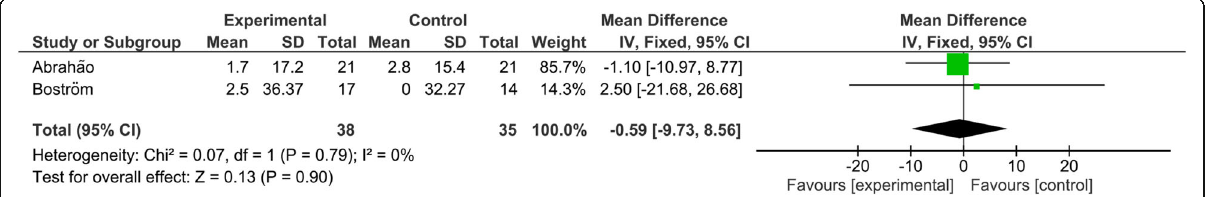
Fig. 5 Forest plot showing the results of the meta-analysis (intervention versus control- Domain